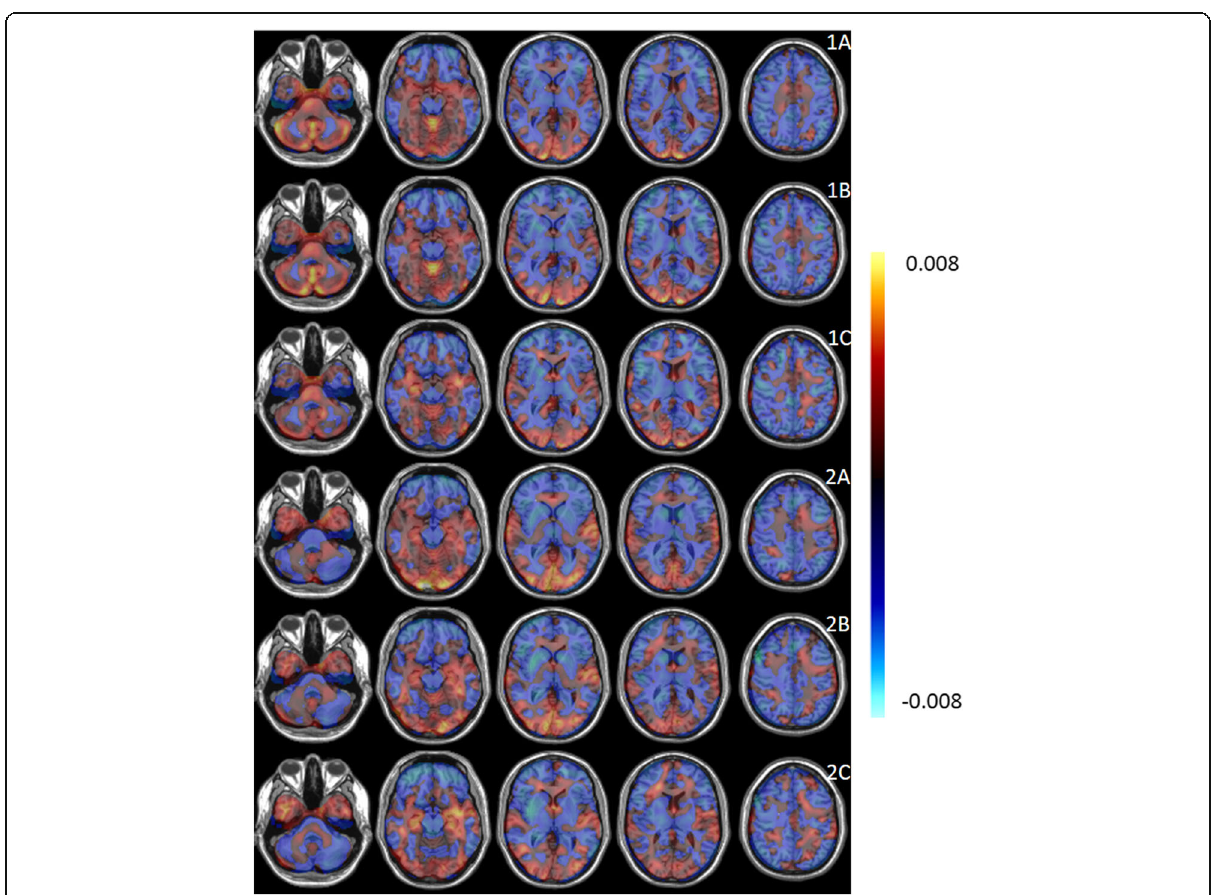
Fig. 4 Disease-specific patterns (arbitrary units) for ALS (1) and PP (2) determined by PCA-LR ( a ), PCA-SVM ( b ), and SVM ( c ). The values in each voxel represent the weights of the contribution of the voxel for the classifier. Positive values (red) indicate regions of hypermetabolism of ALS or PP patients compared to HC whereas negative values (blue) correspond to hypometabolism of ALS or PP patients compared to